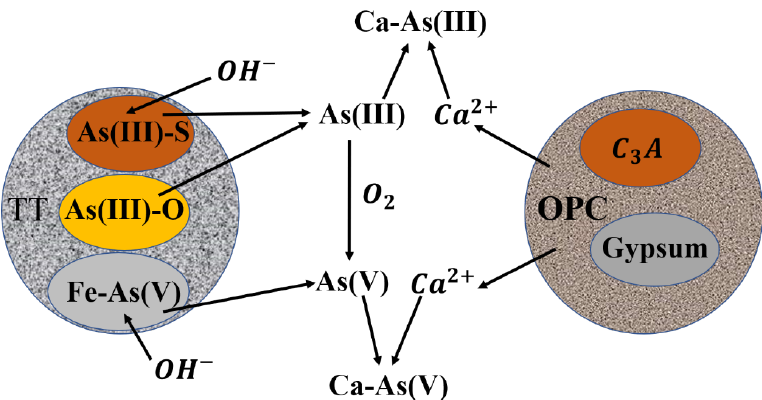
Figure 10. The mechanism of S/S of As in the